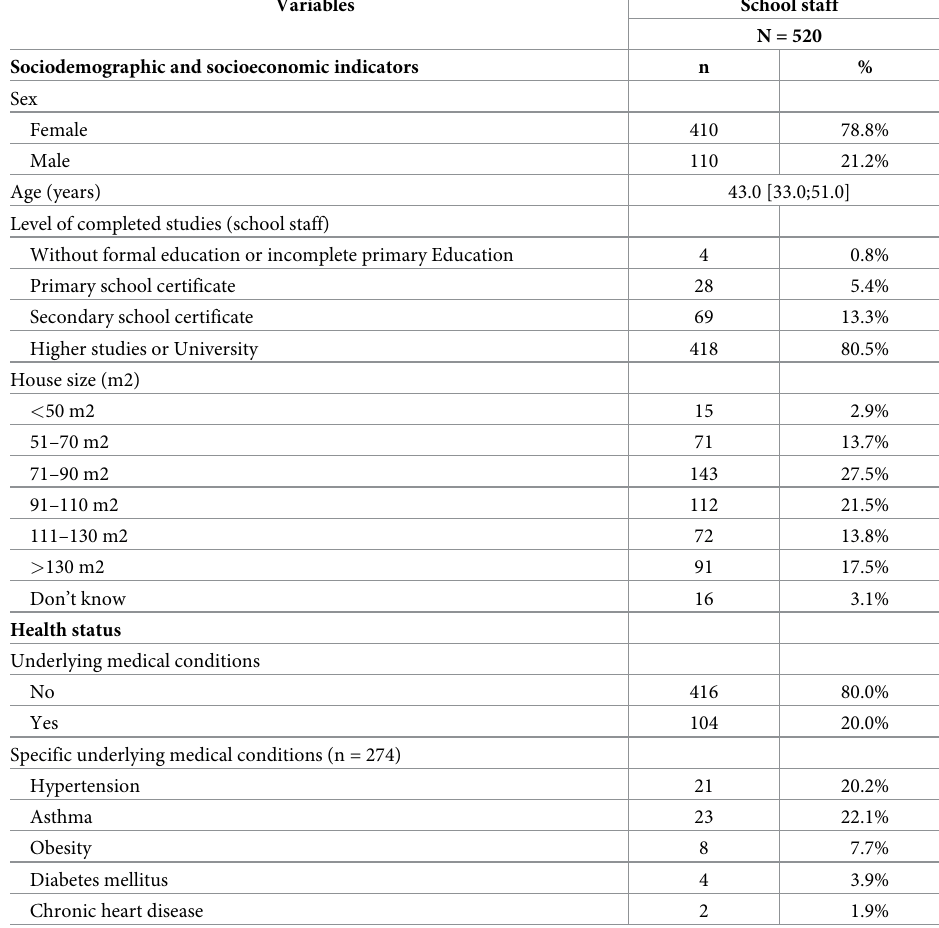
Table 3. General characteristics of the school staff participating in the sentinel school project, Catalonia, Spain. February-March